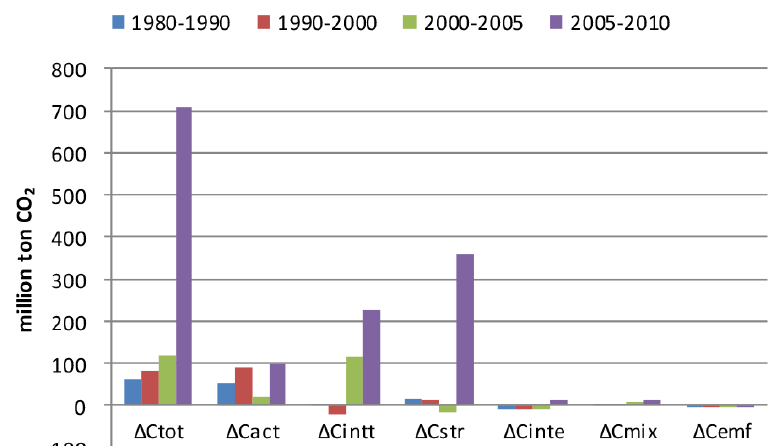
Figure 9. Bar chart for CO 2 emission decomposition in